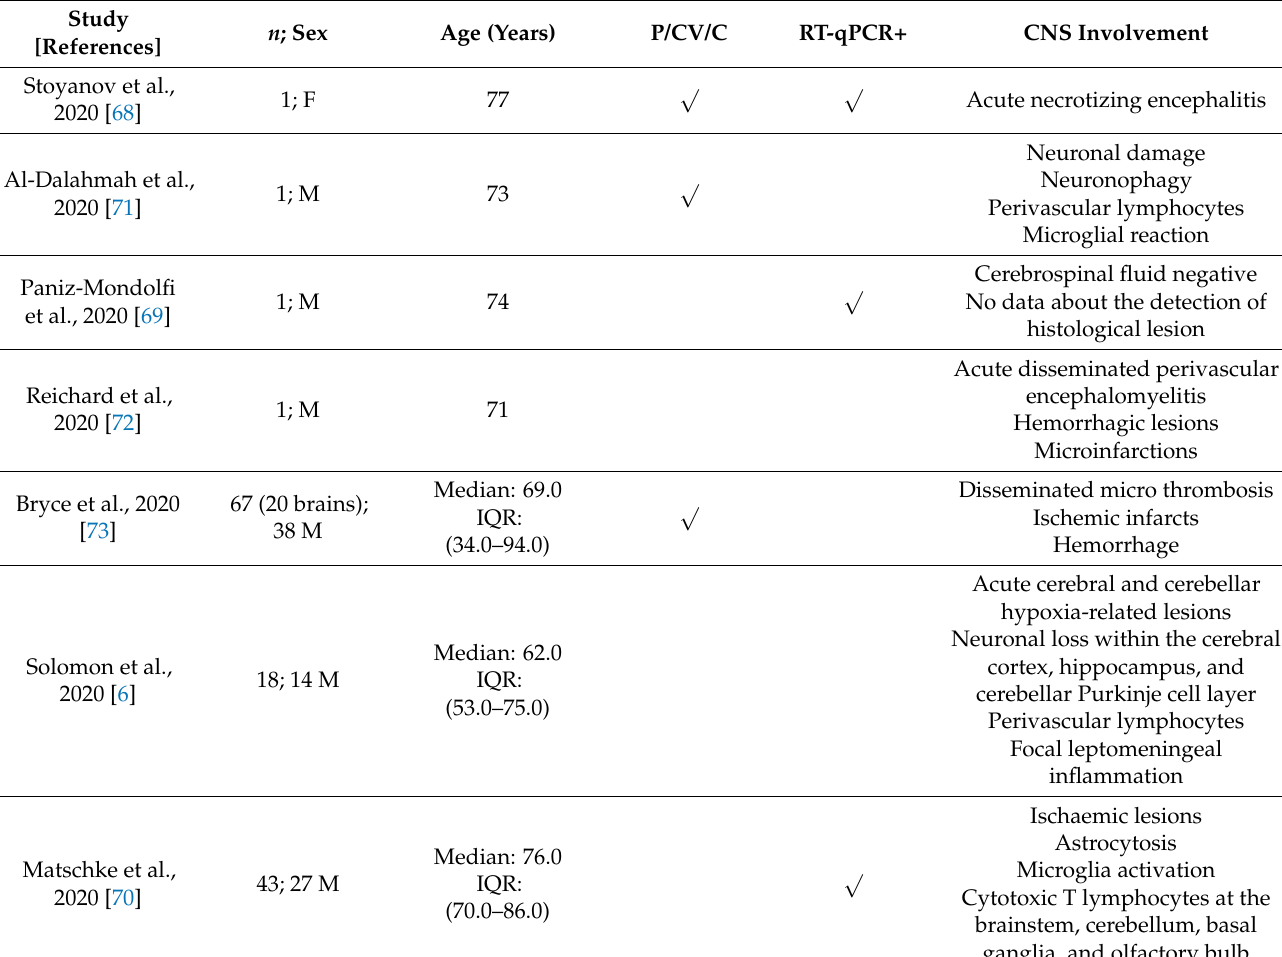
Table 1. Relevant autopsy studies performed during COronaVIrus Disease-19 (COVID-19)